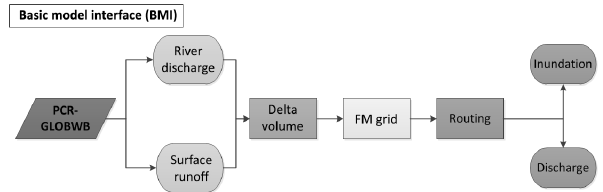
Figure 4. Flow diagram of coupling process steps embedded in the